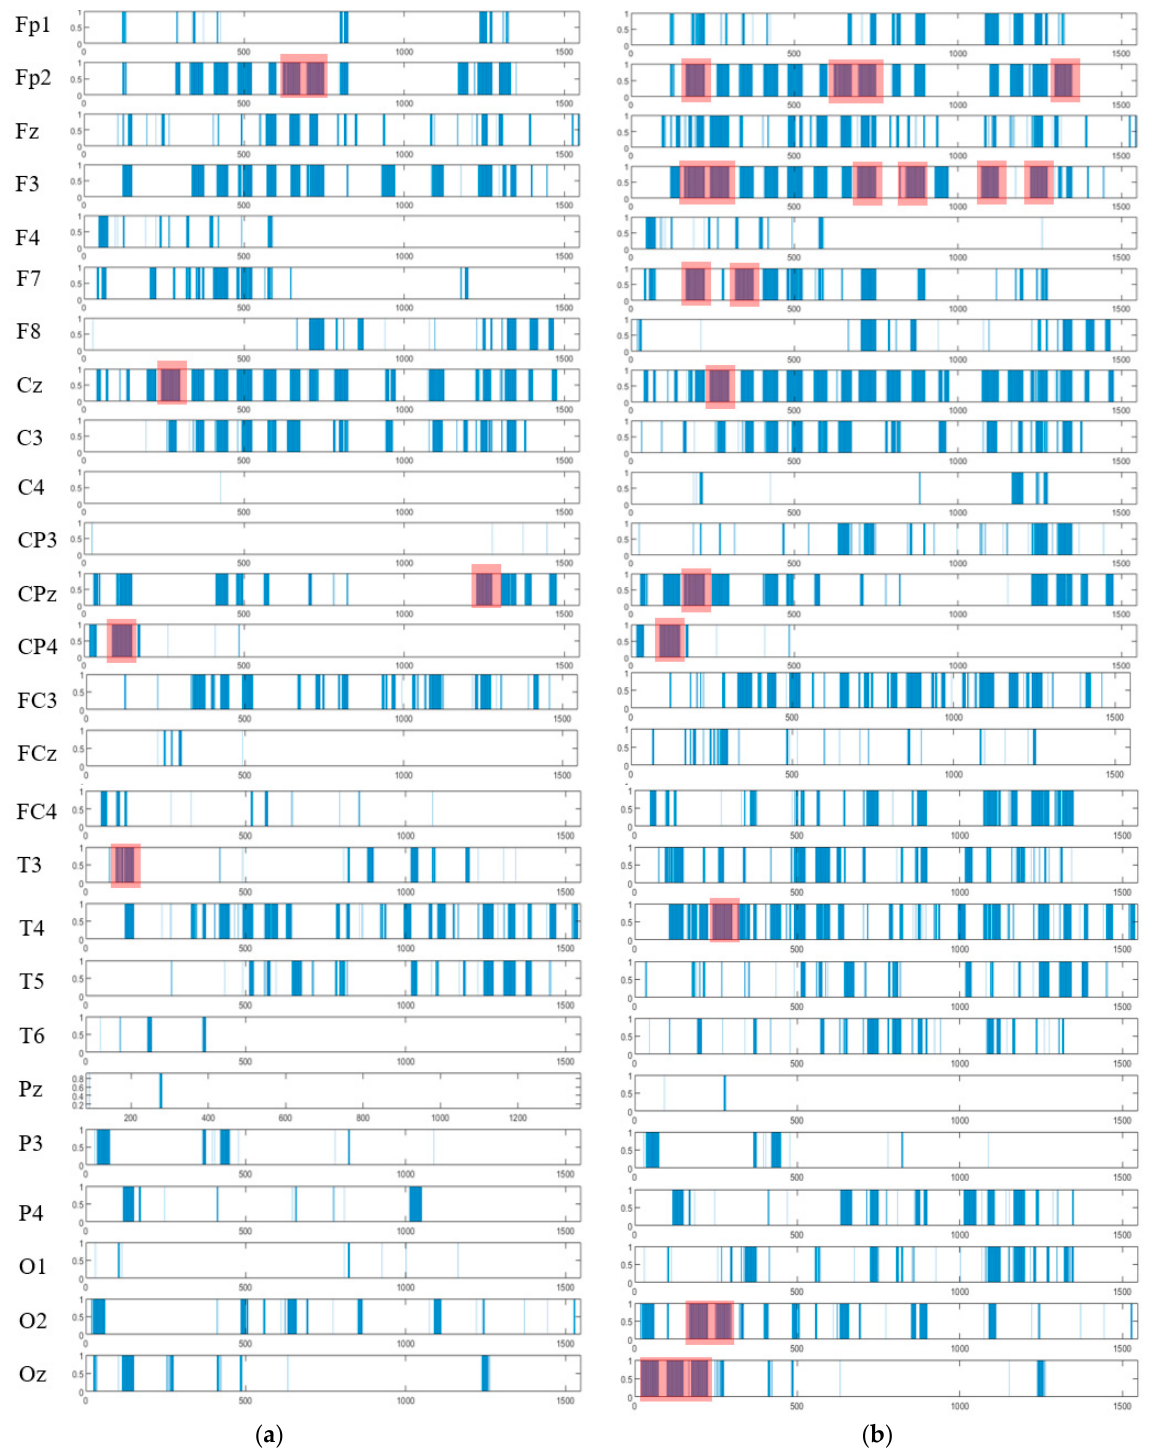
Figure 14. The spatiotemporal spike events (shown in blue bars) are extracted from the PSP patterns (shown in Figure 8) to demonstrate (when) and (where) the neural spike events (denoted as action A) occurred in different groups (control in ( a ) and OP in ( b )). These spikes are events that occurred at different spatial brain regions (neural clusters around EEG channels) and at different times during the STDP learning process with EEG data. In each cluster, the spike events correspond to significant changes in the values of PSP pattern that exceed the spike-emitting-threshold. This allows to investigate which areas of the brain were activated at what time for control vs. OP groups. The red boxes illustrate the spike-event actions, described in Section 3.4.